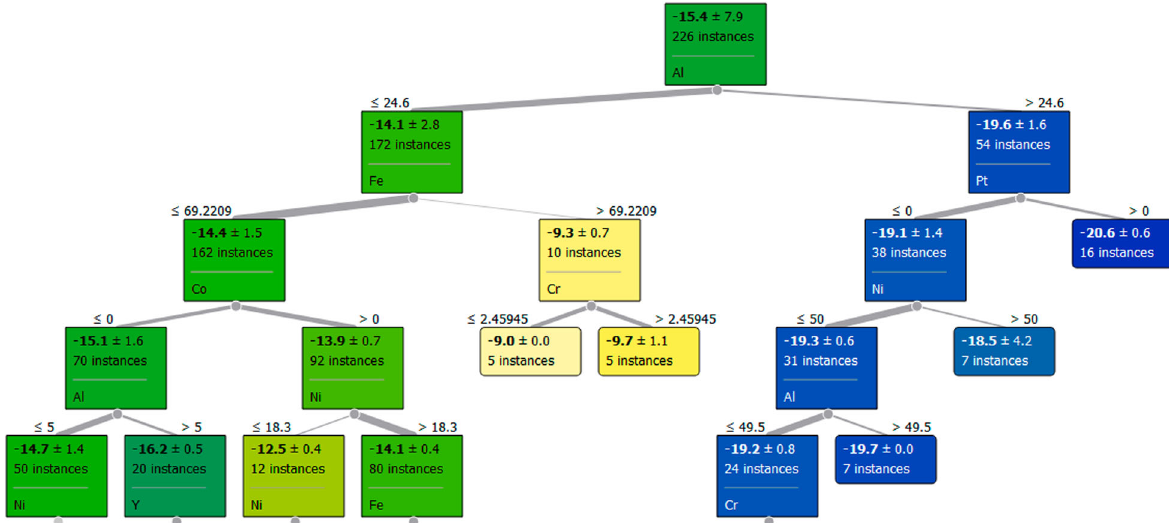
Fig. 3 Decision tree for activation energy proxy based on elemental composition. Decision tree for the determination of the Arrhenius slope based on the elemental composition.